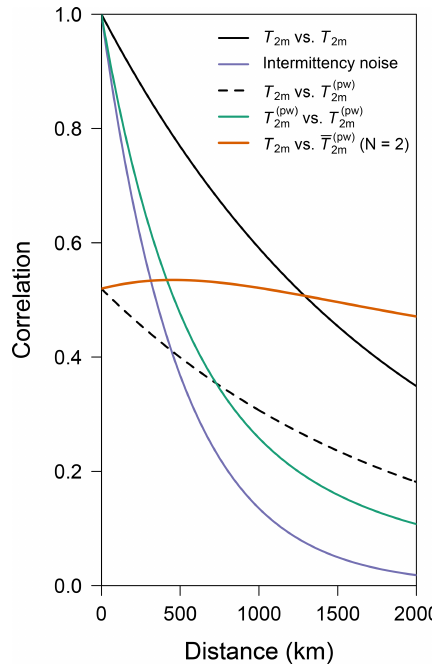
Figure A1. Illustration of the decorrelation lengths in the concep- tual model. Shown as a function of distance are the correlation be- tween two temperature time series (black), between the intermit- tency noise (purple), between a temperature and a precipitation- weighted temperature time series (dashed black), between two precipitation-weighted temperature time series (green), and be- tween a target temperature time series and the average of two precipitation-weighted temperature time series (orange) when one is located at the target site and the other one is located away from the target site at a distance as indicated on the x axis. Model pa- rameters are taken from the DML region. The decorrelation curve of the precipitation-weighted temperature time series is simply the superposition of the temperature decorrelation and the decorrelation of the intermittency noise, depending on the intermittency factor ξ